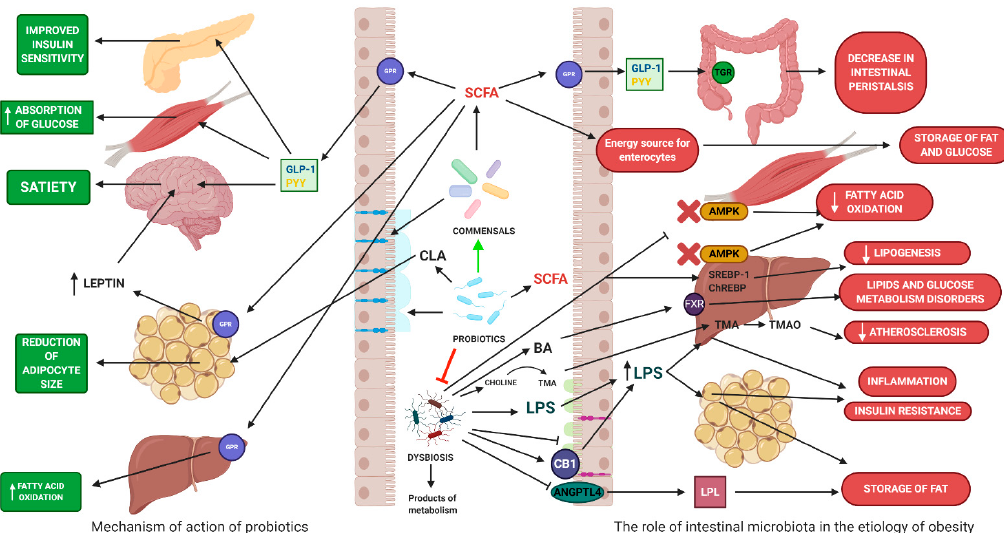
Figure 5. Mechanism of action of probiotics in the gastro intestinal tract: Probiotics increase the variety of intestinal microbiota. Inhibition of growth of pathogenic bacteria. Stimulating SCFA production in the gut. Regulation of appetite. Effects on glucose and lipid metabolism. Positive effect on intestinal barrier tightness. The role of intestinal microbiota in the etiology of obesity: Decreased AMPK expression causes a decrease in β -oxidation in the liver and muscles. Inhibition of ANGPTL4 increases lipoprotein lipase activity, which leads to TG storage in adipose tissue. Lowering GLP-1 levels disrupts the host’s response to insulin. Low levels of PYY cause more hunger. An increased hepatic lipogenesis by activating acetyl CoA carboxylase and fatty acid synthase. The development of inflammation in adipose tissue is caused by LPS. Stimulation of GPR 41/43 receptors increases lipolysis in adipose tissue. Activation of CB1 receptors. Abbreviations: SCFA—short chain fatty acids, GPR41/43—G-protein coupled receptor 41/43, GLP1—Glucagon Like Protein 1, PYY—peptide